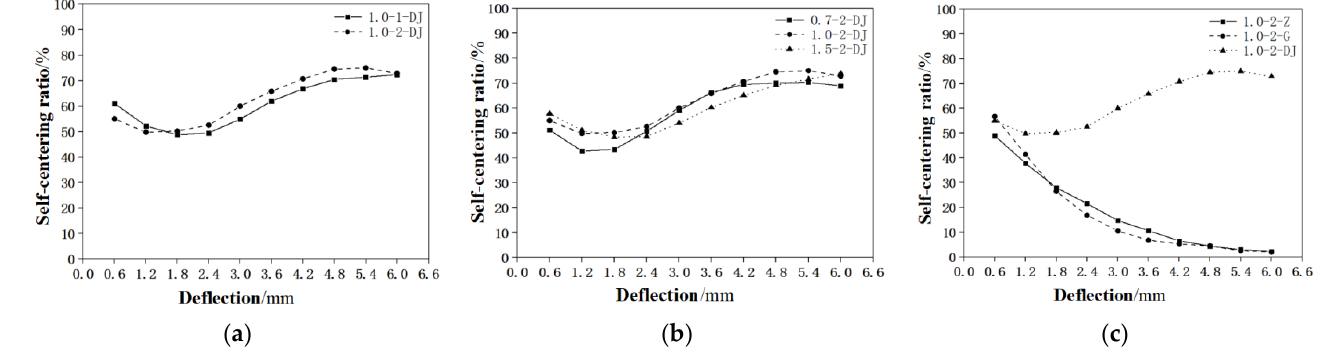
Figure 11. Comparison of the influence on self-centering ratio according to different factors: ( a ) Fiber content; ( b ) Fiber diameter; ( c ) Fiber end form. content; ( b ) Fiber diameter; ( c ) Fiber end